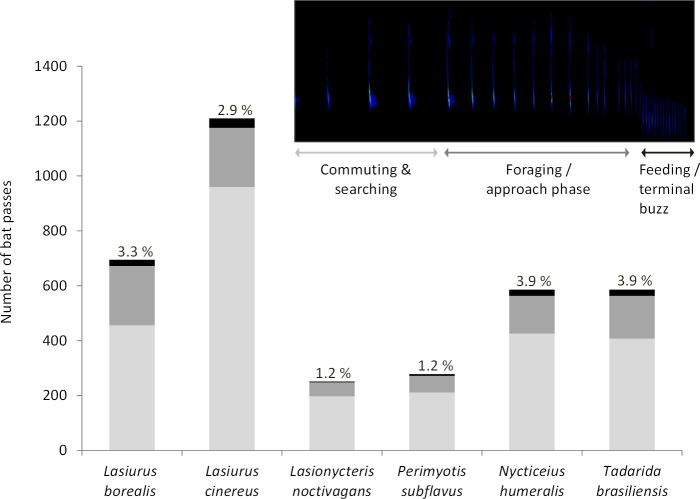
Number of bat passes recorded at turbine towers.Number of bat passes, separated into 3 activity categories (light grey, commuting & searching; dark grey, foraging/approach phase; black, feeding/terminal buzz), by species recorded in acoustic surveys at wind turbine towers in 2010, 2012, 2013, 2015, and 2016 at the Wolf Ridge wind farm. The percentage of bat passes that included feeding or terminal buzz activity is included above each species’ bar.